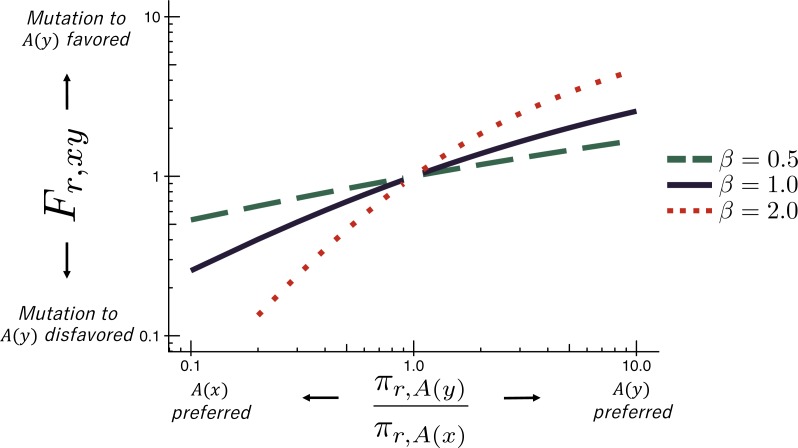
The ExpCM fixation term Fr,xy.In an ExpCM, the rate of fixation of a mutation from codon x to codon y depends on the experimentally measured preferences of the amino acids \documentclass[12pt]{minimal}
\usepackage{amsmath}
\usepackage{wasysym}
\usepackage{amsfonts}
\usepackage{amssymb}
\usepackage{amsbsy}
\usepackage{upgreek}
\usepackage{mathrsfs}
\setlength{\oddsidemargin}{-69pt}
\begin{document}
}{}$A \left( x \right) $\end{document}Ax and \documentclass[12pt]{minimal}
\usepackage{amsmath}
\usepackage{wasysym}
\usepackage{amsfonts}
\usepackage{amssymb}
\usepackage{amsbsy}
\usepackage{upgreek}
\usepackage{mathrsfs}
\setlength{\oddsidemargin}{-69pt}
\begin{document}
}{}$A \left( y \right) $\end{document}Ay encoded by these codons. Mutations to preferred amino acids, with \documentclass[12pt]{minimal}
\usepackage{amsmath}
\usepackage{wasysym}
\usepackage{amsfonts}
\usepackage{amssymb}
\usepackage{amsbsy}
\usepackage{upgreek}
\usepackage{mathrsfs}
\setlength{\oddsidemargin}{-69pt}
\begin{document}
}{}$ \frac{{\pi }_{r,A \left( y \right) }}{{\pi }_{r,A \left( x \right) }} \gt 1$\end{document}πr,Ayπr,Ax>1, result in a larger Fr,xy, and so are anticipated to fix more often. The value of Fr,xy is modulated by re-scaling the preferences by a stringency parameter β ≠ 1 to reflect differences in selection between the lab and nature. When β > 1, the selection for preferred amino acids is exaggerated. When β < 1, the selection for preferred amino acids is attenuated.